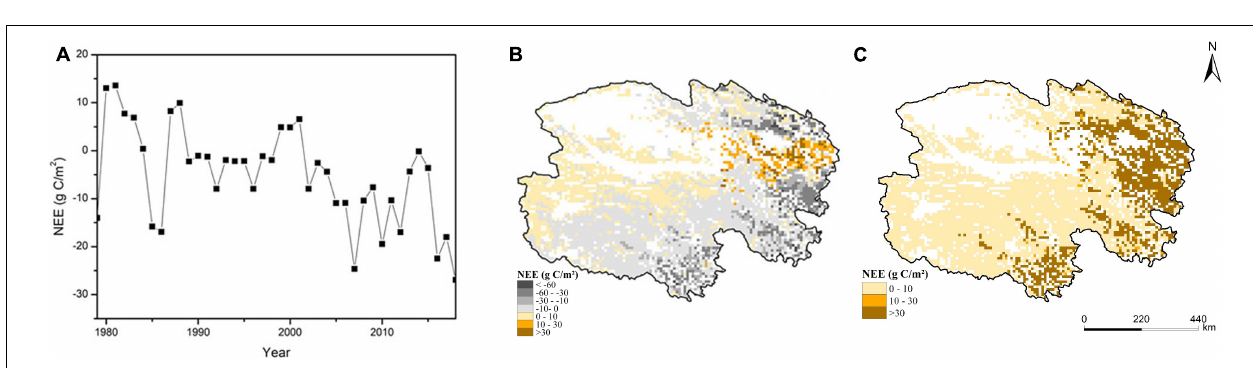
FIGURE 4 | Temporal (A) and spatial (B) dynamics of NEE and the map of its standard deviation (C) in Qinghai grasslands from 1979 to